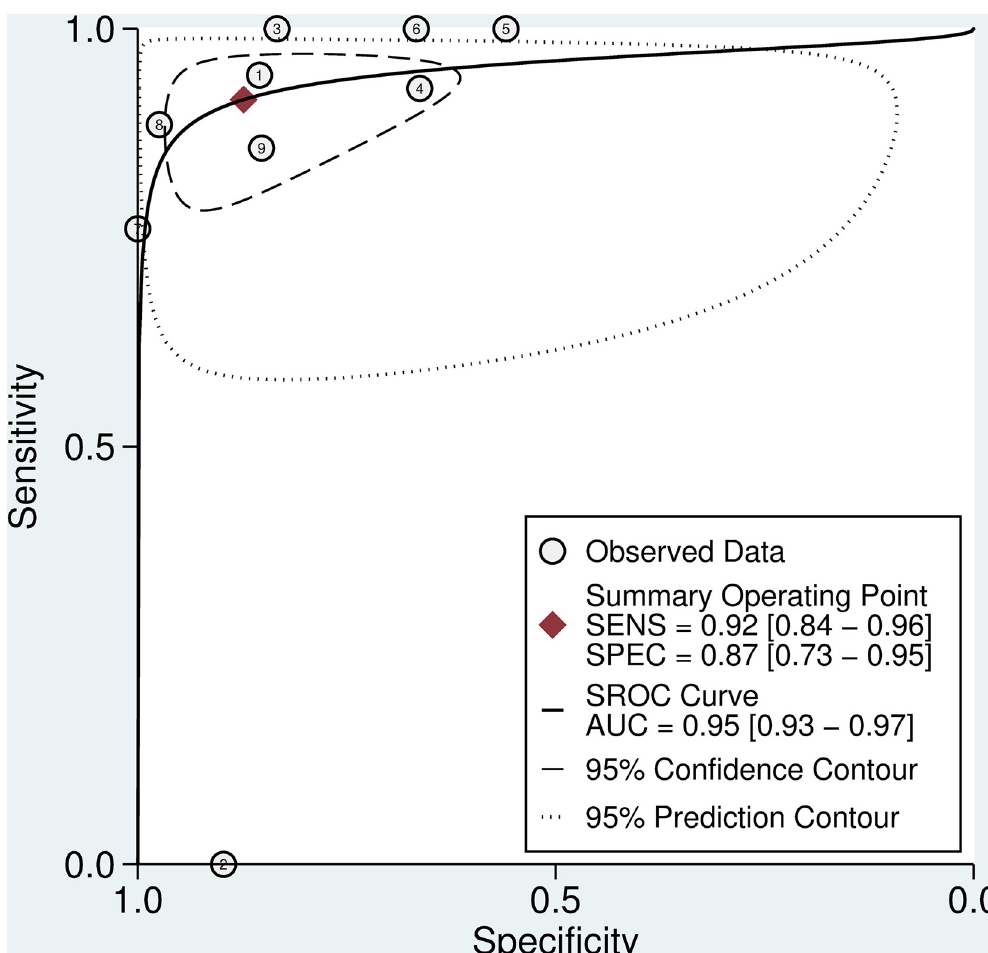
Fig 5. SROC curve for 20WBCT at detecting coagulopathy. SROC curves for 20WBCT at detecting mild coagulopathy defined as fibrinogen < 100